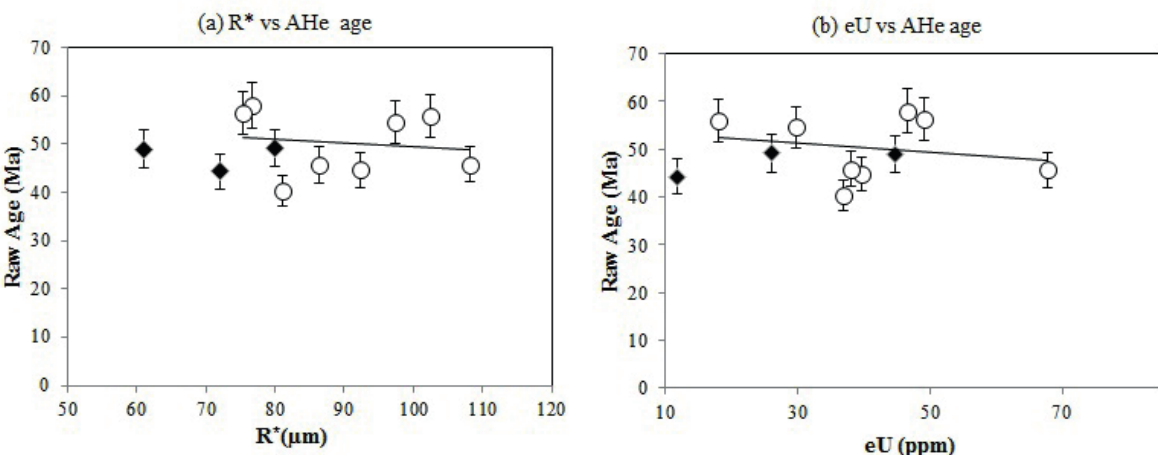
Figure 6 - ( a ) Single-grain AHe ages plotted against grain spherical equivalent radius (R*); ( b ) single-grain Ahe age plotted against eU (effective uranium; [U ppm] + (0.237*[Th ppm]). White circles and black diamonds circles represent samples analyzed in the rio Claro and SUErC he laboratories, respectively.